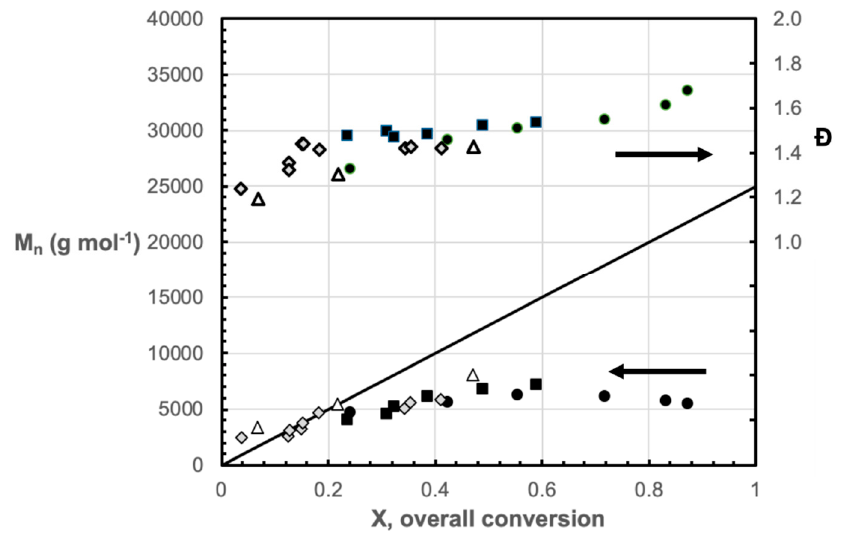
Figure 5. Number average molecular weight M n and dispersity Đ versus overall conversion (X) for DBI / S copolymerizations at composition f DBI,0 = 0.5 at various temperatures: at ( a ) 110 ◦ C (filled circles (cid:8) ), ( b ) 100 ◦ C (filled squares (cid:4) ), ( c ) 80 ◦ C (open diamonds ¯) and ( d ) 70 ◦ C (open triangles (cid:52)